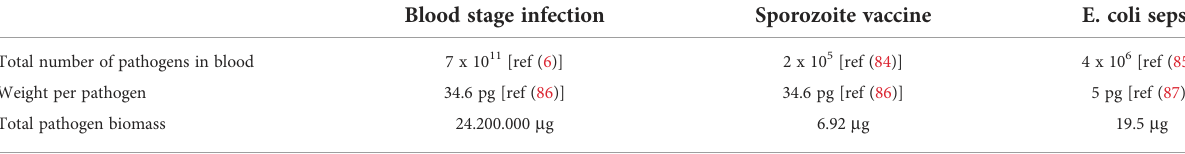
TABLE 1 Comparison of pathogen numbers and biomass during P. falciparum blood stage infection, sporozoite vaccination and E. coli mediated sepsis. Blood stage